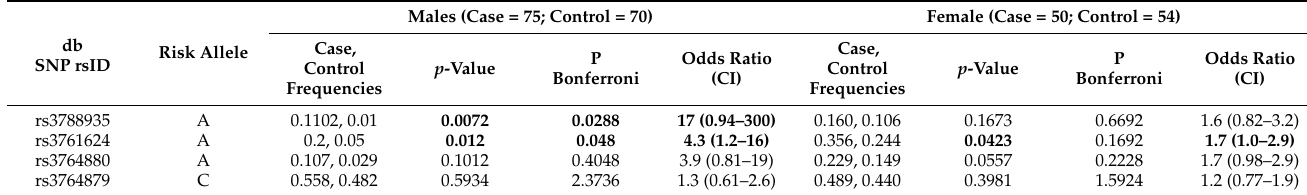
Table 7. Sex-specific associations for TLR8 gene variants in